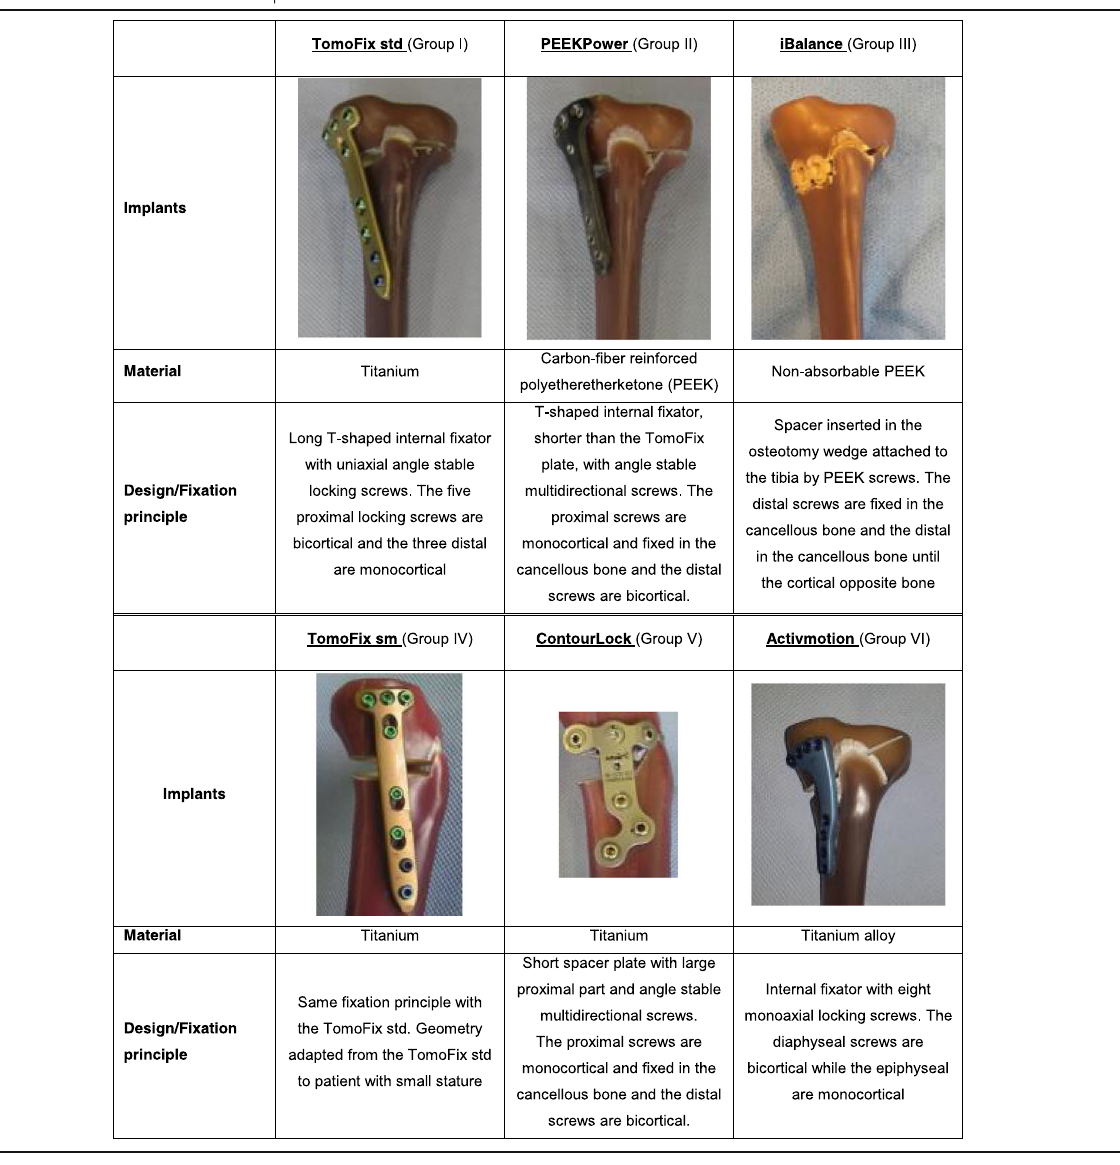
Table 1 Different HTO implants considered in the present study. The plates are precontoured to fit the proximal tibia head. The ContourLock is wider than the other plates